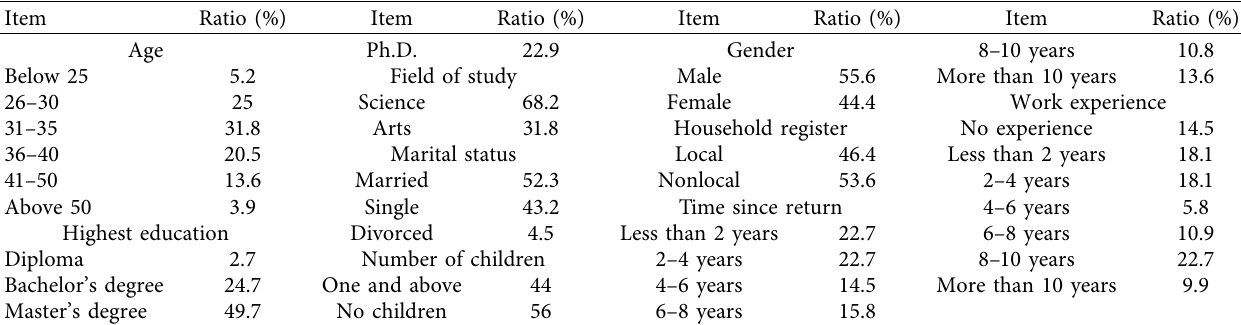
Table 2: Basic information about the sample.